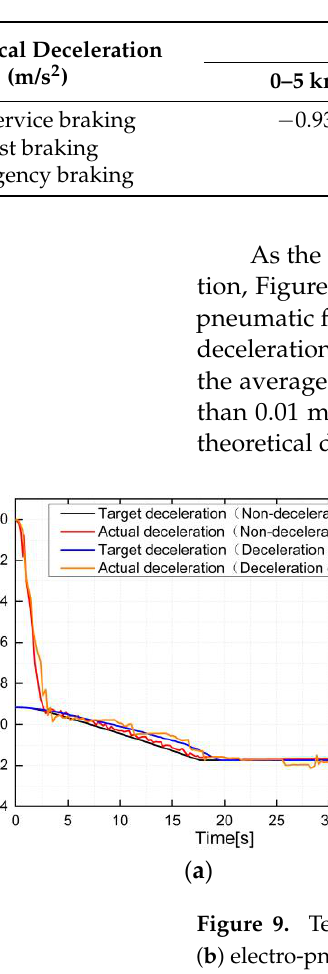
Table 1. Theoretical deceleration definition in the test.